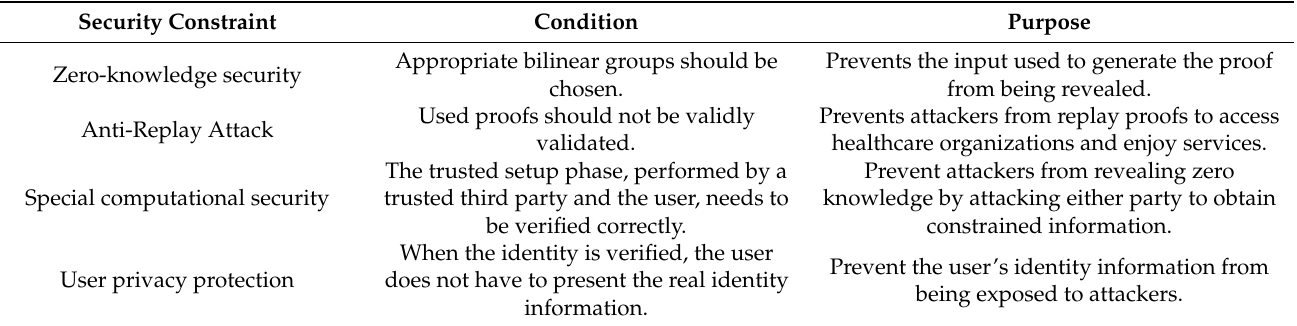
Table 8. Security constraints of